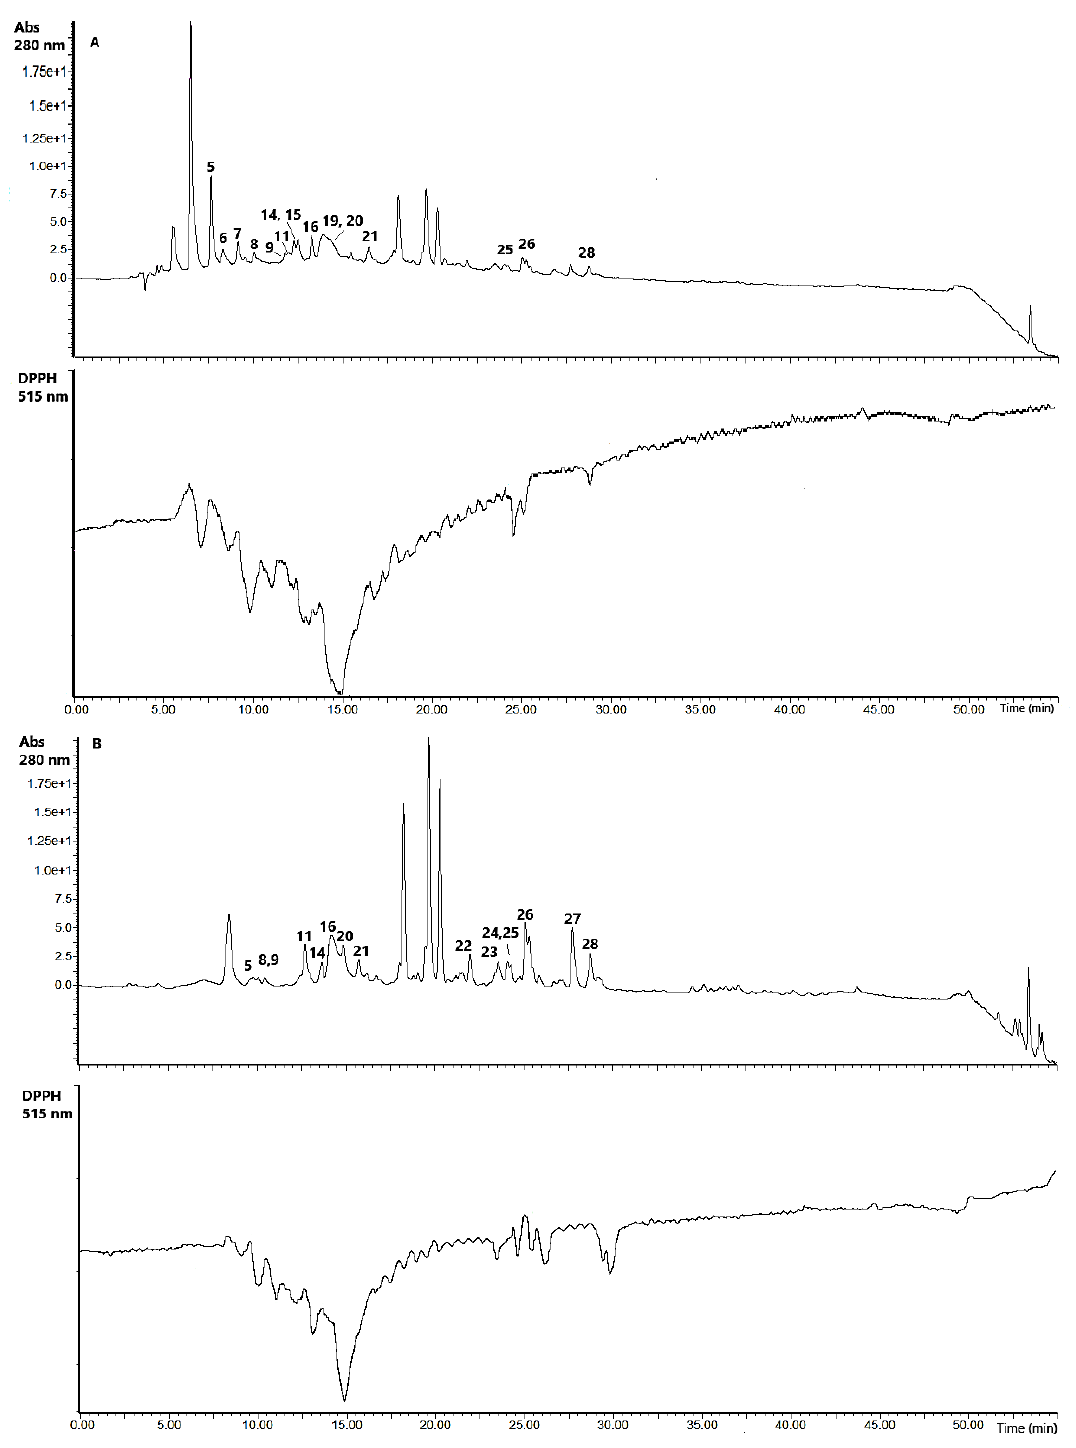
Figure 3. HPLC-UV-DPPH • -scavenging chromatograms of water ( A ) and ethanol ( B ) extracts of SBP.